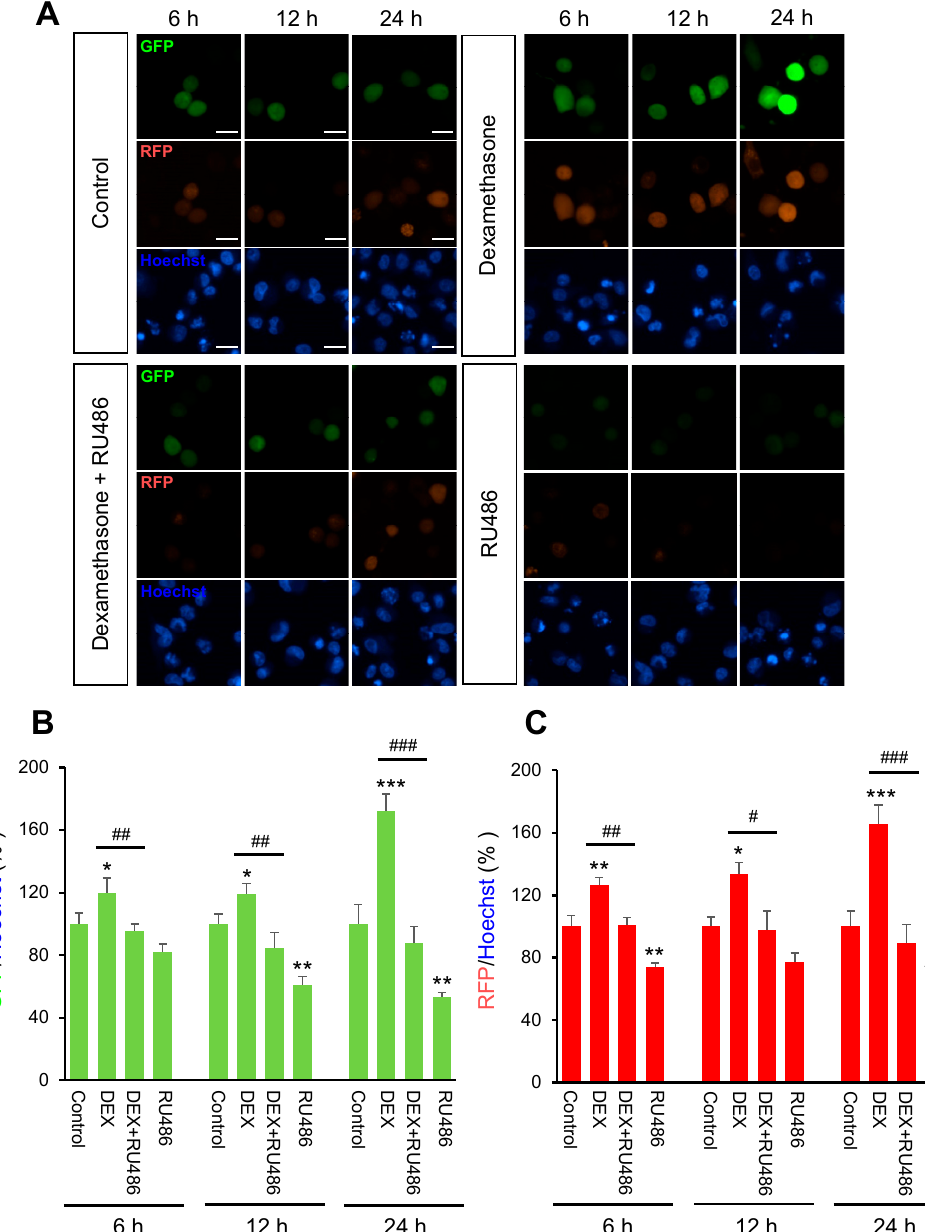
Figure 1. The intracellular calcium levels under dexamethasone treatment for 6, 12, and 24 h. A549 cells were seeded at 3 × 10 5 in coverglass-bottom dish for microscopy and co-transfected with 0.5 µ g of pGP-CMV-GCaMP6f and CMV-R-GECO1.2 then 1.5 µ L of Lipofectamine in 50 µ L of Opti-MEM medium at room temperature for 5 min. Intracellular calcium levels were increased by dexamethasone (DEX) treatment for 6, 12, and 24 h after pGP-CMV-GCaMP6f and CMV-R-GECO1.2 transfection. Increased intracellular calcium levels by DEX were determined by using lionheart microscopy. ( A ) Expression of pGP-CMV-GCaMP6f (green) and CMV-R-GECO1.2 (red) detected after 6, 12, and 24 h co-transfection. Nuclei were stained with Hoechst (blue). ( B ) The green fluorescent protein (GFP) intensities by pGP-CMV-GCaMP6f (green) were plotted for each of the 6, 12, and 24 h groups. ( C ) The red fluorescent protein (RFP) intensities by CMV-R-GECO1.2 (red) were plotted for each of the 6, 12, and 24 h groups. * p < 0.05, ** p < 0.01, *** p < 0.001 versus control; # p < 0.05, ## p < 0.01, ### p < 0.001 versus DEX. Scale bar, 25 µ